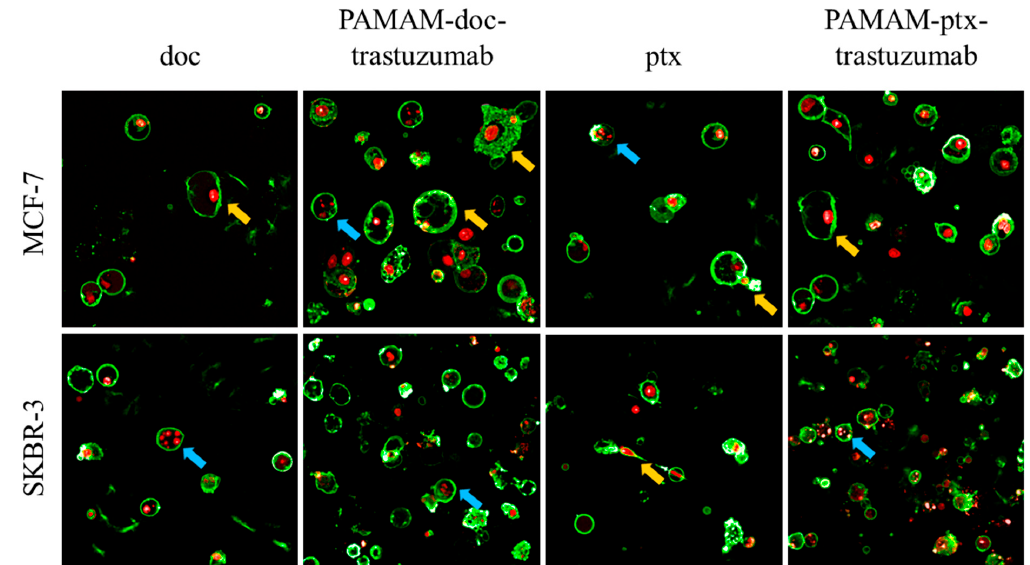
Figure 5. Representative confocal images of MCF-7 and SKBR-3 cells after a 24 h incubation period with the analysed compounds. The cells were stained with Annexin V and propidium iodide (PI). After drug treatment, a strong green fluorescence (derived from Annexin-V FITC) in the cells with phosphatidylserine translocated from the inner layer of the plasma membrane to the outer layer was noticed, which is characteristic for symptoms of programmed cell death. Cancer cells treated with investigated drugs present abnormal morphology: Chromatin condensation and fragmentation (marked by the blue arrows ), giant cells and elongated cells with protrusions from the plasma membrane and cytoplasmic bridges between cells (marked by the yellow arrows ). For interpretation of the references to colour in this fi gure legend, the reader is referred to the web version of this article.